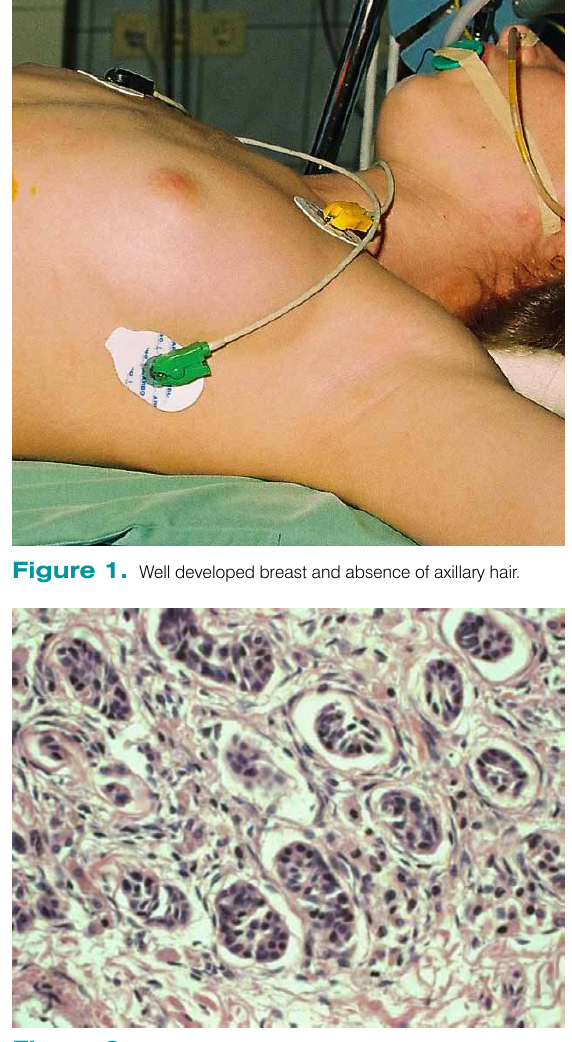
Figure 2. Immature testis with seminiferous tubules with Sertoli and spermatogonal cells. Grouped Laydig cells